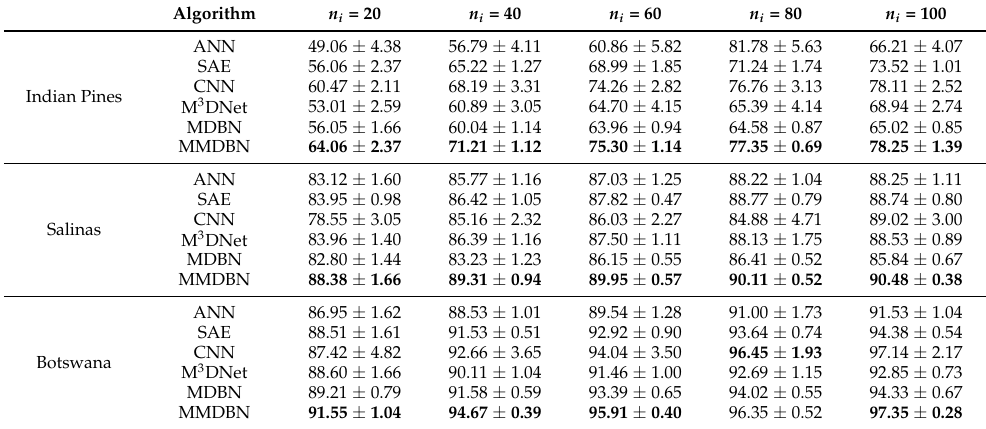
Table 7. The classification results for different deep learning methods (overall accuracy ± Std (%)). Algorithm